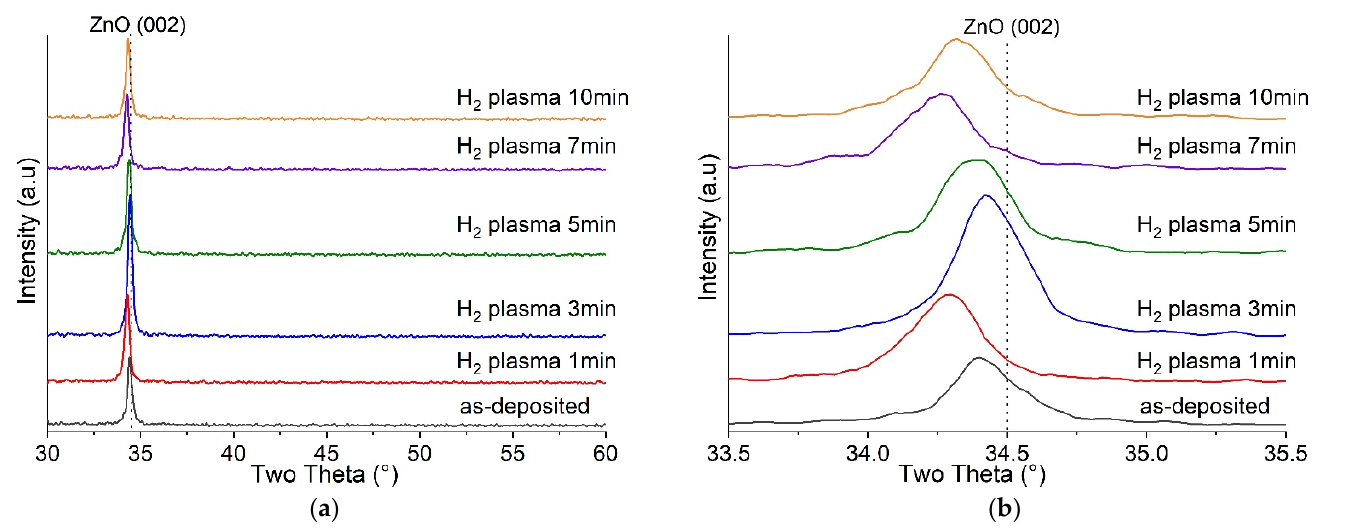
Figure 2. XRD spectra of the hydrogen-plasma-processed GAZO films. According to the standard ZnO XRD pattern of ICSD 31052, the black dotted lines represent the XRD peak position of (002) of ZnO. ( a ) The XRD spectra of the all samples is exhibited with the 2 θ = 30 ‒ 60 ˚ , ( b ) a magnified (002) peak. Table 1. Structural, electrical and optical properties and emissivity of the as-deposited and hydro- gen-plasma-processed GAZO films.